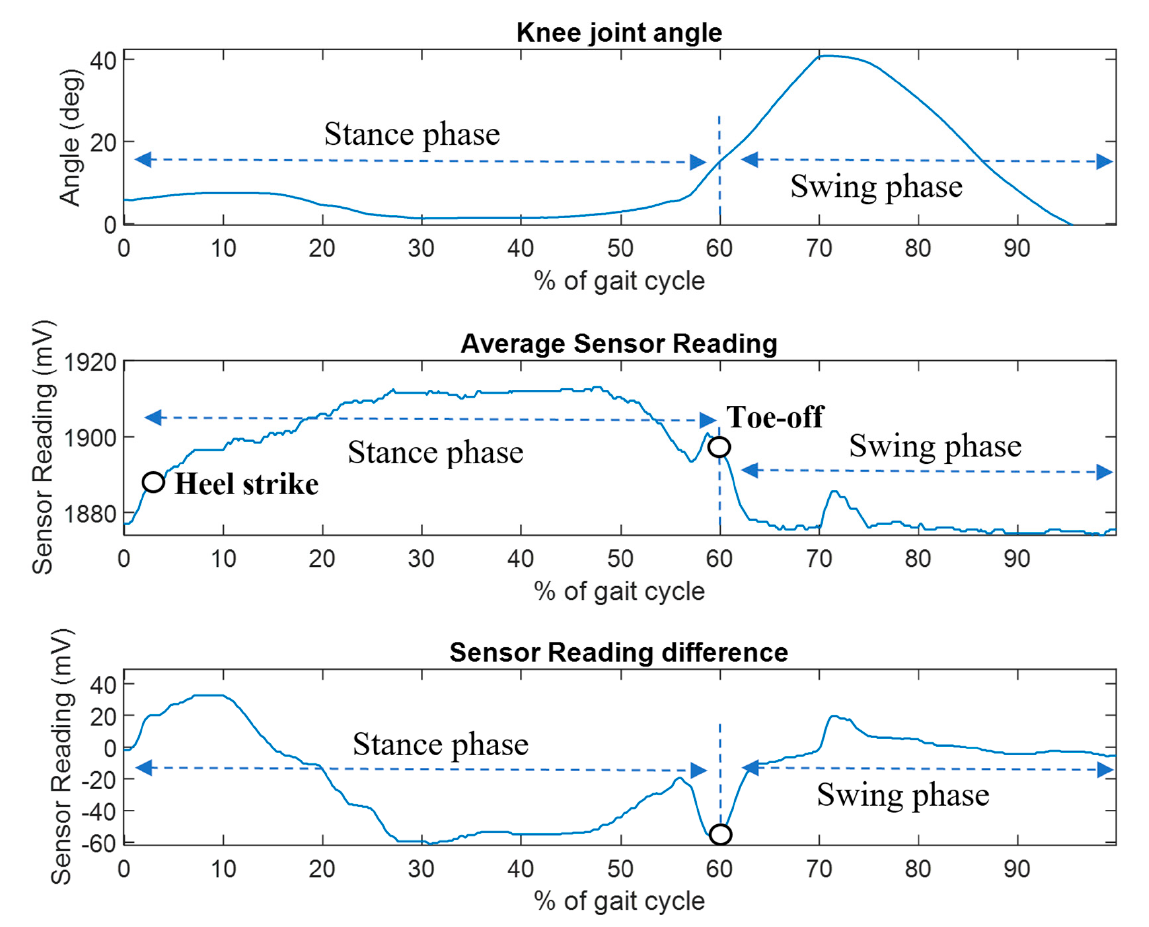
Figure 16. FM-PLS walking test: knee angle ( top figure ), average sensor reading ( middle figure ), and sensor reading difference ( bottom figure ).